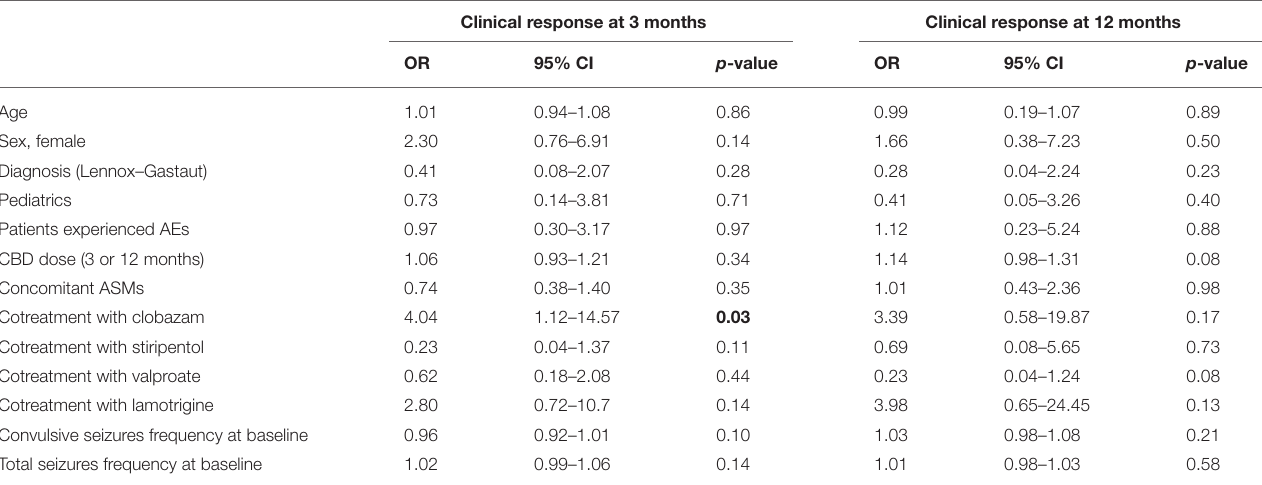
TABLE 5 | Multivariate regressions with selected variables for clinical